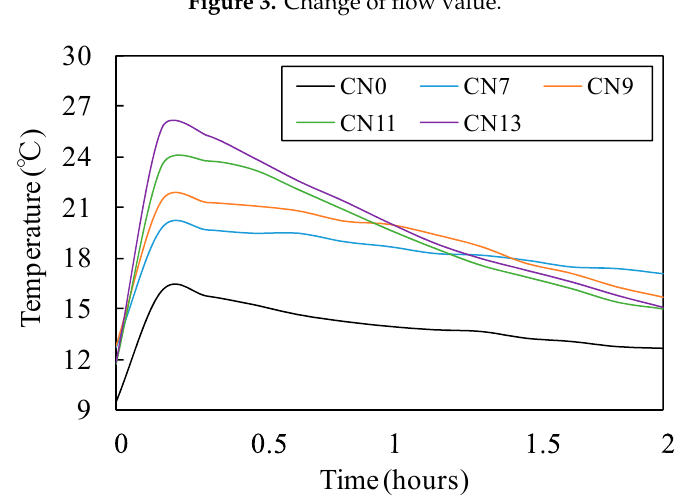
Materials 2019 , 12 , x; doi: FOR PEER REVIEW